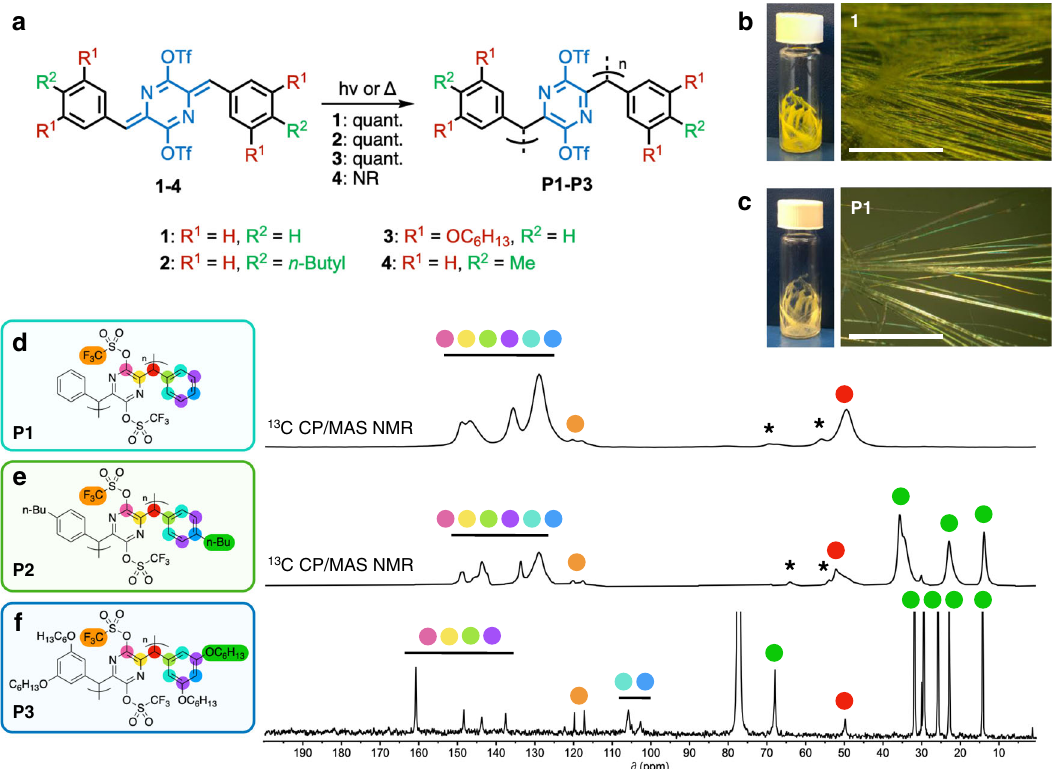
Fig. 1 Single-crystal polymerization of a family of AQM ditri fl ates. a The structures of the AQM ditri fl ates, 1 – 4 , studied herein. Monomers 1 – 3 underwent topochemical polymerization under the effects of heat and/or light to produce polymers P1 – P3 . NR: no reaction. b – c Photographs and optical microscope images of vials containing crystals of ( b ) 1 and ( c ) P1 , showing the typical morphology of crystals. Scale bar: 1 mm. d – f 13 C-NMR spectra of polymers P1 – P3 . Cross-polarization/magic angle spinning (CP/MAS) solid-state 13 C-NMR spectra of ( d ) P1 , and ( e ) P2 (asterisks denote spinning side bands). ( f ) Solution – f between 49 – 53 ppm (red) 13 C-NMR spectrum of P3 (solvent: CDCl 3 ). All carbon resonances are annotated by colored circles. The resonances in d indicate the presence of the sp 3 carbons generated during polymerization, and the CF 3 multiplets (expected ratio of 1:3:3:1, but only the two highest peaks are observed) between 117 and 120 ppm (orange) show that the tri fl ate groups remain